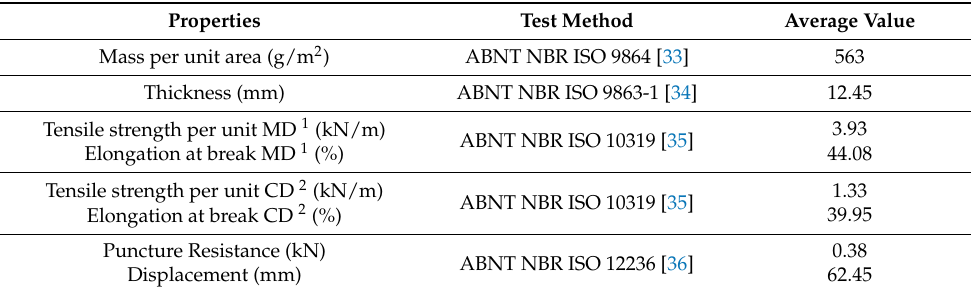
Figure 5. Geomat used in the erosion control techniques. Table 3. Geomat properties.